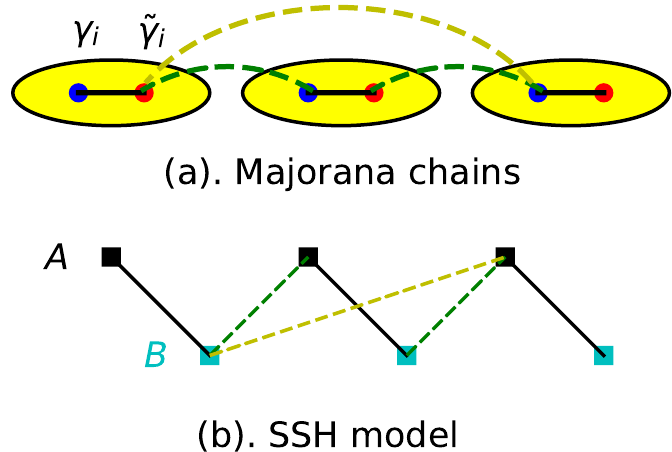
Figure 2: (Color online) Models with three unit cells are plotted to illustrate the hoppings and pairings. (a) Majorana chain. A single fermion is decomposed into two Majorana fermions, shown as blue and red dots. Black lines represent t / t dashed green / yellow lines represents t hoppings (and pairings) in Eq. 4. (b) 1 2 SSH model. Black / cyan rectangular dots represent A / B sublattices. Black, green and yellow lines represent u , u and u hoppings in Eq. 0 1 2